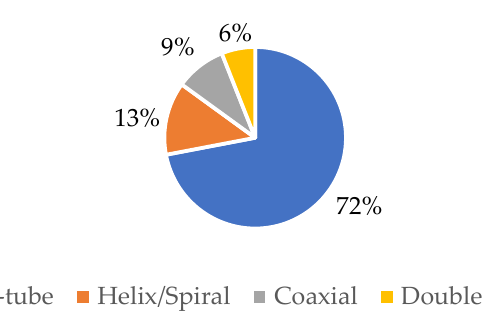
Figure 1. Usage of various GHEX types, numbers adapted from [4].